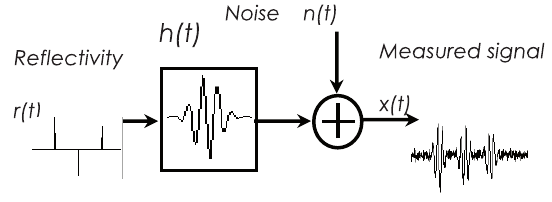
Fig. 3. System model for